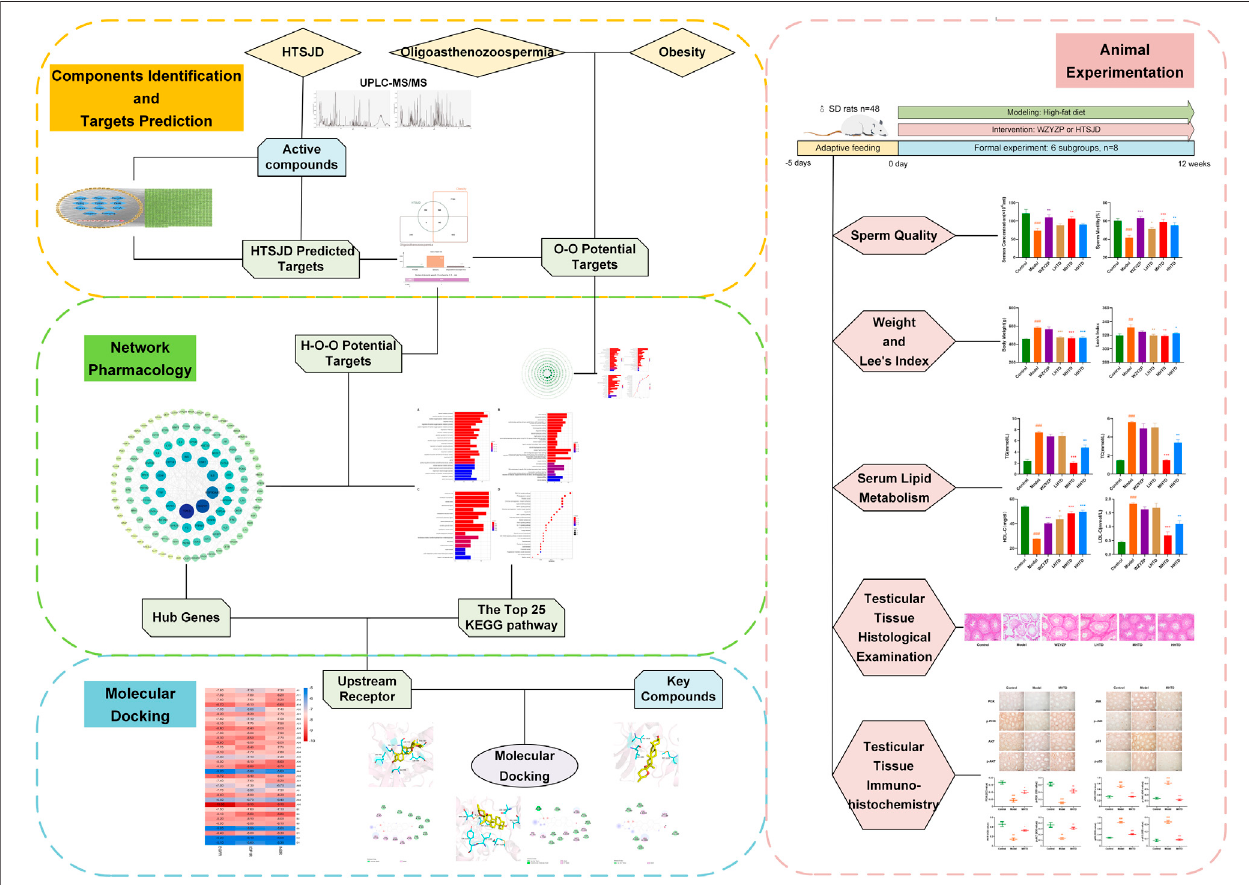
FIGURE 1 | Flow chart for exploring the mechanism of obesity and oligoasthenozoospermia treatment by HTSJD.